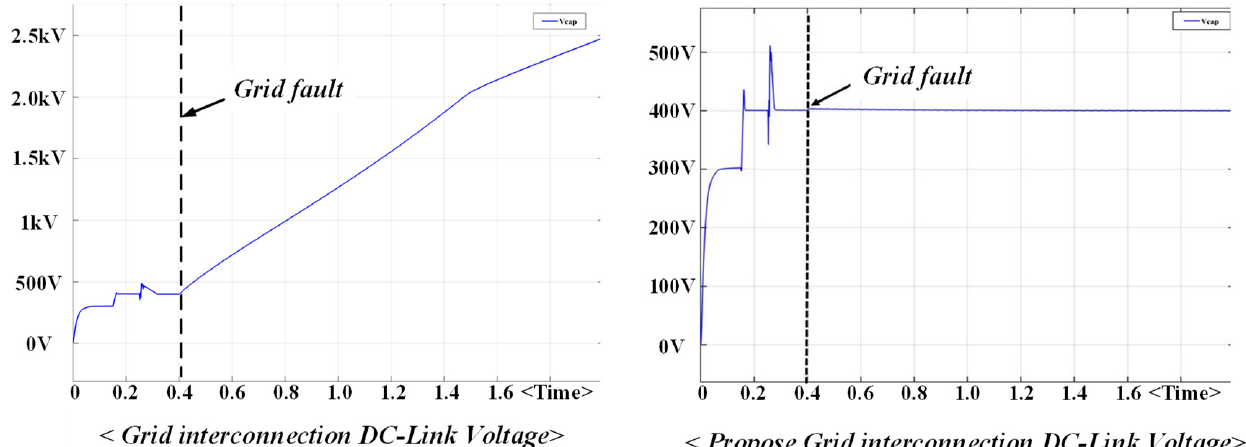
Figure 20. DC_link voltage.